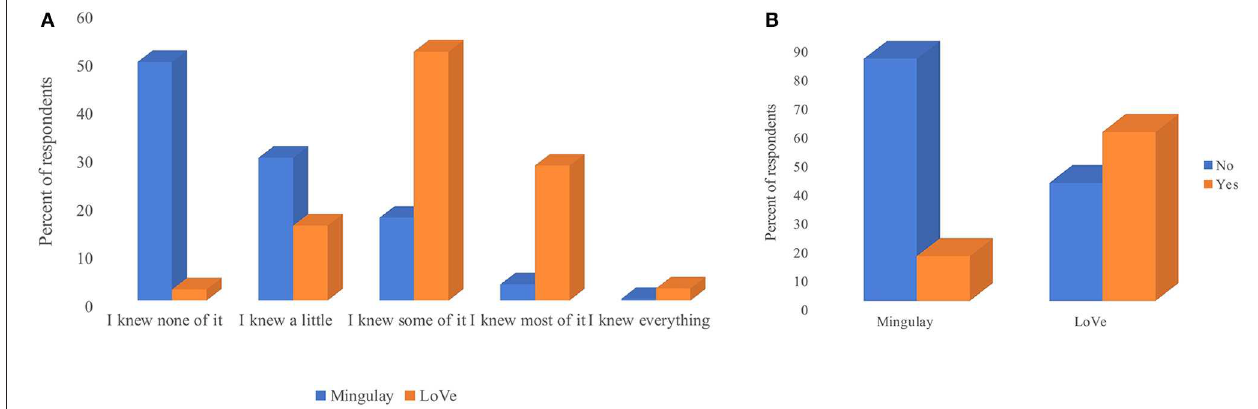
FIGURE 3 | (A) Prior knowledge of the deep-sea and wildlife information. (B) Awareness of cold-water coral reefs.